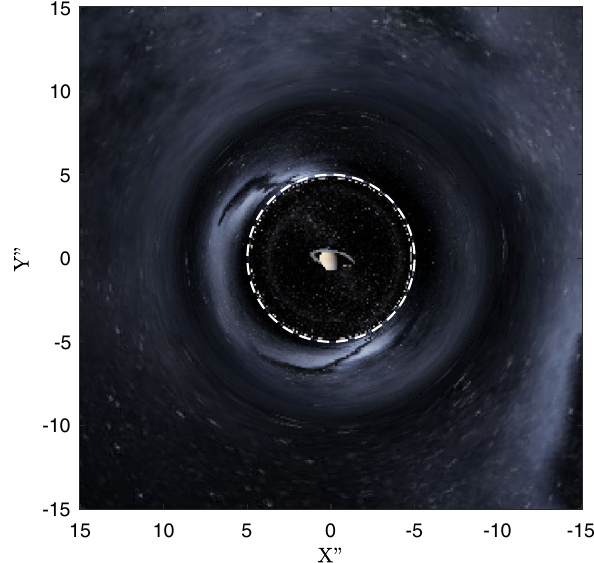
Fig. 8 Apparent image of a Morris and Thorne-like WH in metric theory of gravity [13]. We set b 0 = 5, r skyph = 8 b 0 (computational domain limit or infinite), (cid:14) L p = b 0 / 50, and d plate = 4 b 0 . The white dashed circle represents the WH mouth size b 0 . Credits for textures used in this image to